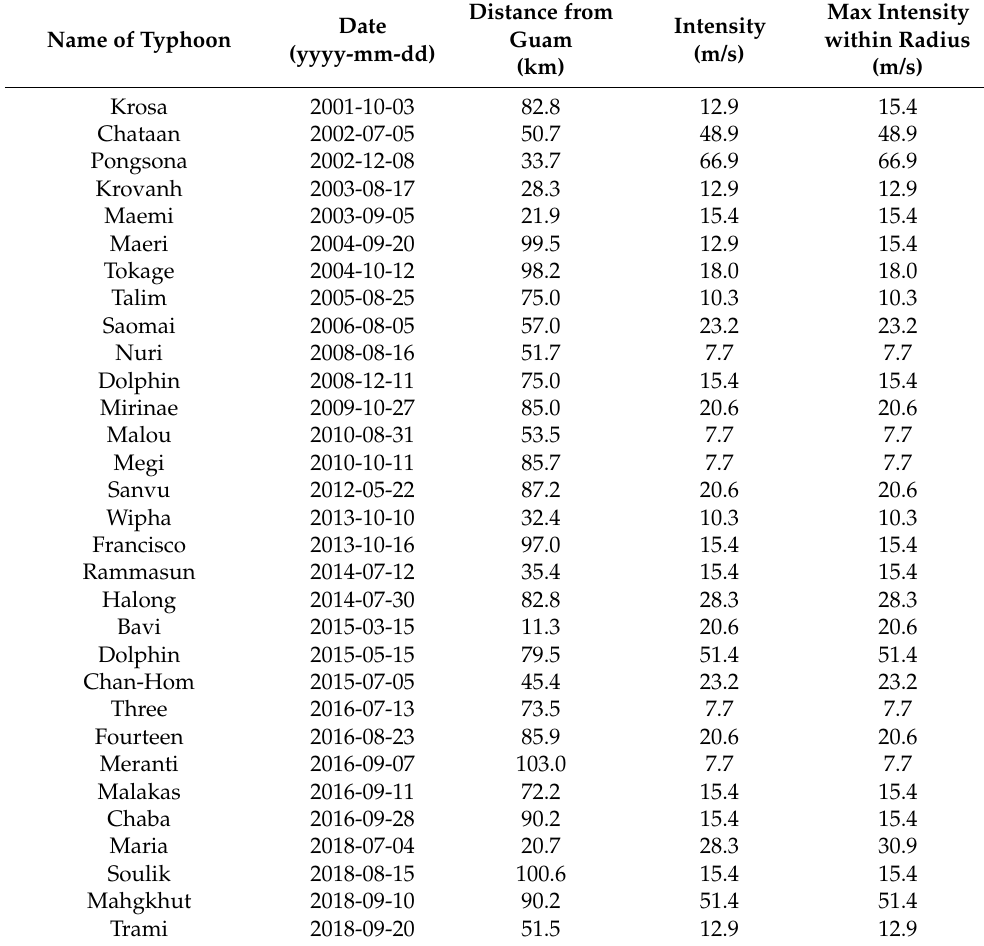
Table 2. Information about typhoons reaching to within 60 nm of